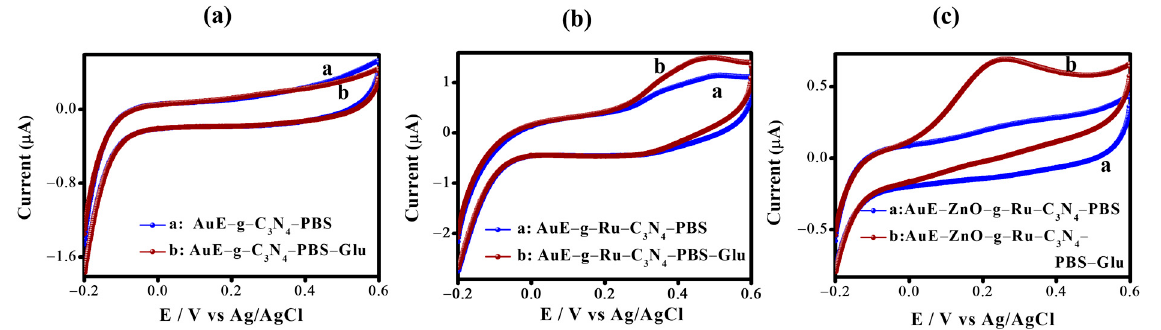
Figure 3. CV behavior of g–C 3 N 4 ( a ), g–Ru–C 3 N 4 ( b ) and ZnO–g–Ru–C 3 N 4 ( c ) modified electrode and used for the glucose sensing. Measured in PBS in the absences (curve a) and presences (curve b) of 1 mM glucose at a scan rate 50 mV s − 1